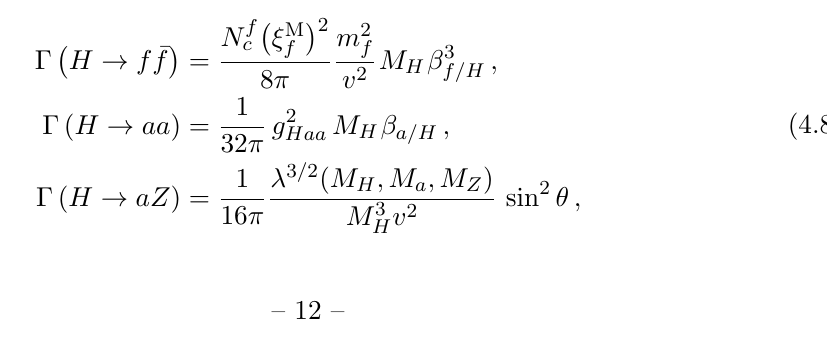
p 2, (cid:21) 3 = (cid:21) P 1 = (cid:21) P 2 = 0